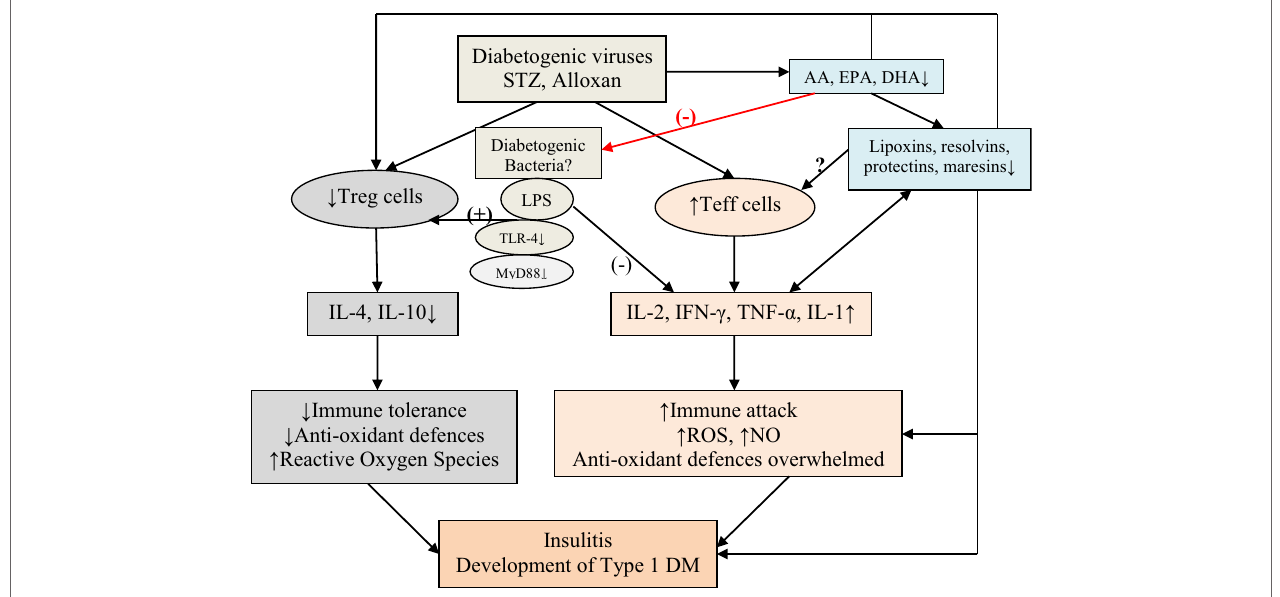
FiGUre 1 | Scheme showing probable mechanism by which diabetogenic viruses, streptozotocin (STZ), and alloxan induce the development of type 1 diabetes mellitus (type 1 DM). The same mechanism may occur in non-obese diabetic (NOD) and other animals that are known to develop type 1 DM. Bacterial endotoxin lipopolysaccharide (LPS), an agonist of toll-like receptor-4 (TLR-4), inhibits type 1 DM. LPS administered to NOD mice during the prediabetic state delays the onset and decreases the incidence of diabetes. A multiple-injection protocol of LPS is more effective than a single LPS intervention. LPS administration suppresses spleen T lymphocyte proliferation, increases the generation of T regulatory cells [indicated as ( + ) in the figure], and reduces the synthesis of T-helper 1 pro-inflammatory cytokines [indicated as ( − ) in the figure], and downregulates TLR-4 and its downstream MyD88-dependent signaling pathway and enhances IL-4 and IL-10. Multiple injections of LPS induce tolerogenic dendritic cell (DC) subset with low TLR-4 expression and, thus, prevent development of type 1 DM in NOD diabetic mice see text, Figure 2 , and Wang et al. (47). Alloxan and STZ and other diabetogenic molecules, including viruses, may block activity of desaturases and, thus, decrease the formation of arachidonic acid, eicosapentaneoic acid, and docosahexaenoic acid that, in turn, leads to deficiency of lipoxins, resolvins, protectins, and maresins, potent anti-inflammatory substances. Polyunsaturated fatty acid and their products may alter gut microbiota and regulate Treg and Teff cells. Bioactive lipids inhibit production of pro-inflammatory cytokines and possess cytoprotective actions that may explain their ability to prevent type 1 DM (see Figures 6 – 8